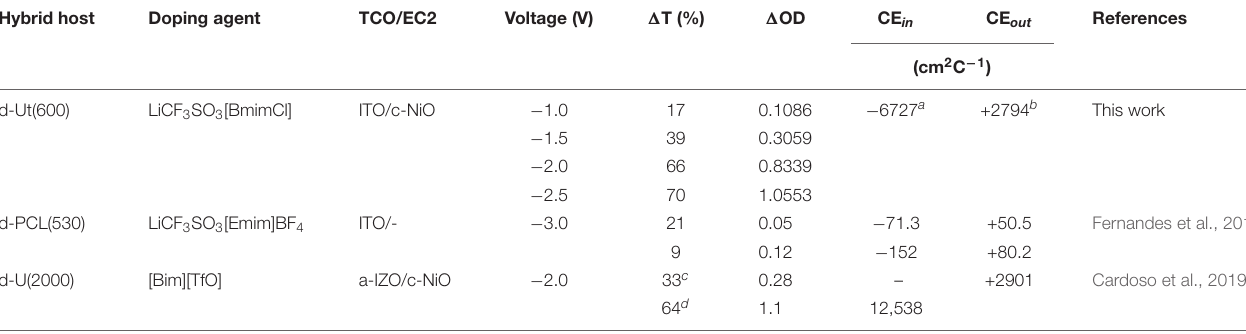
TABLE 2 | Electro-optical parameters of ECDs with the configuration glass/TCO/WO 3 /ormolyte/EC2/TCO/glass. Hybrid host Doping agent TCO/EC2